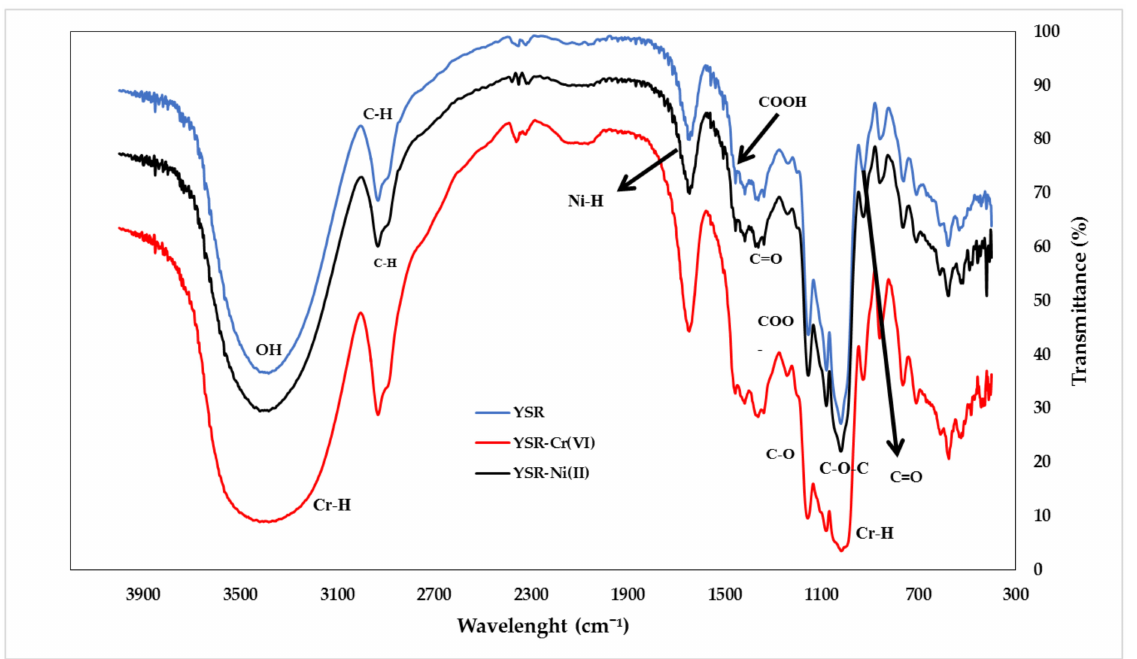
Figure 2. IR spectrum of YSR before and after removal of Cr (VI) and Ni (II). The presence of Cr (VI) and Ni (II) metal ions within the surface structure of the biomass is evidenced in Figures 1 and 2, the increase in the width of the spectral bands and the slight decrease in intensity for each of the adsorption processes, the infrared spectroscopy after the adsorption process of Ni (II) being the one that shows a slightly more noticeable decrease in intensity. For both metals, such decrease provided by the variation of the adsorption frequency can be attributed to the binding of Cr (VI) and Ni (II) ions to the different functional groups present in the biomass, as corroborated by the change in the intensity and width of the adsorption peak at 2341 cm − 1 , due to the interaction of